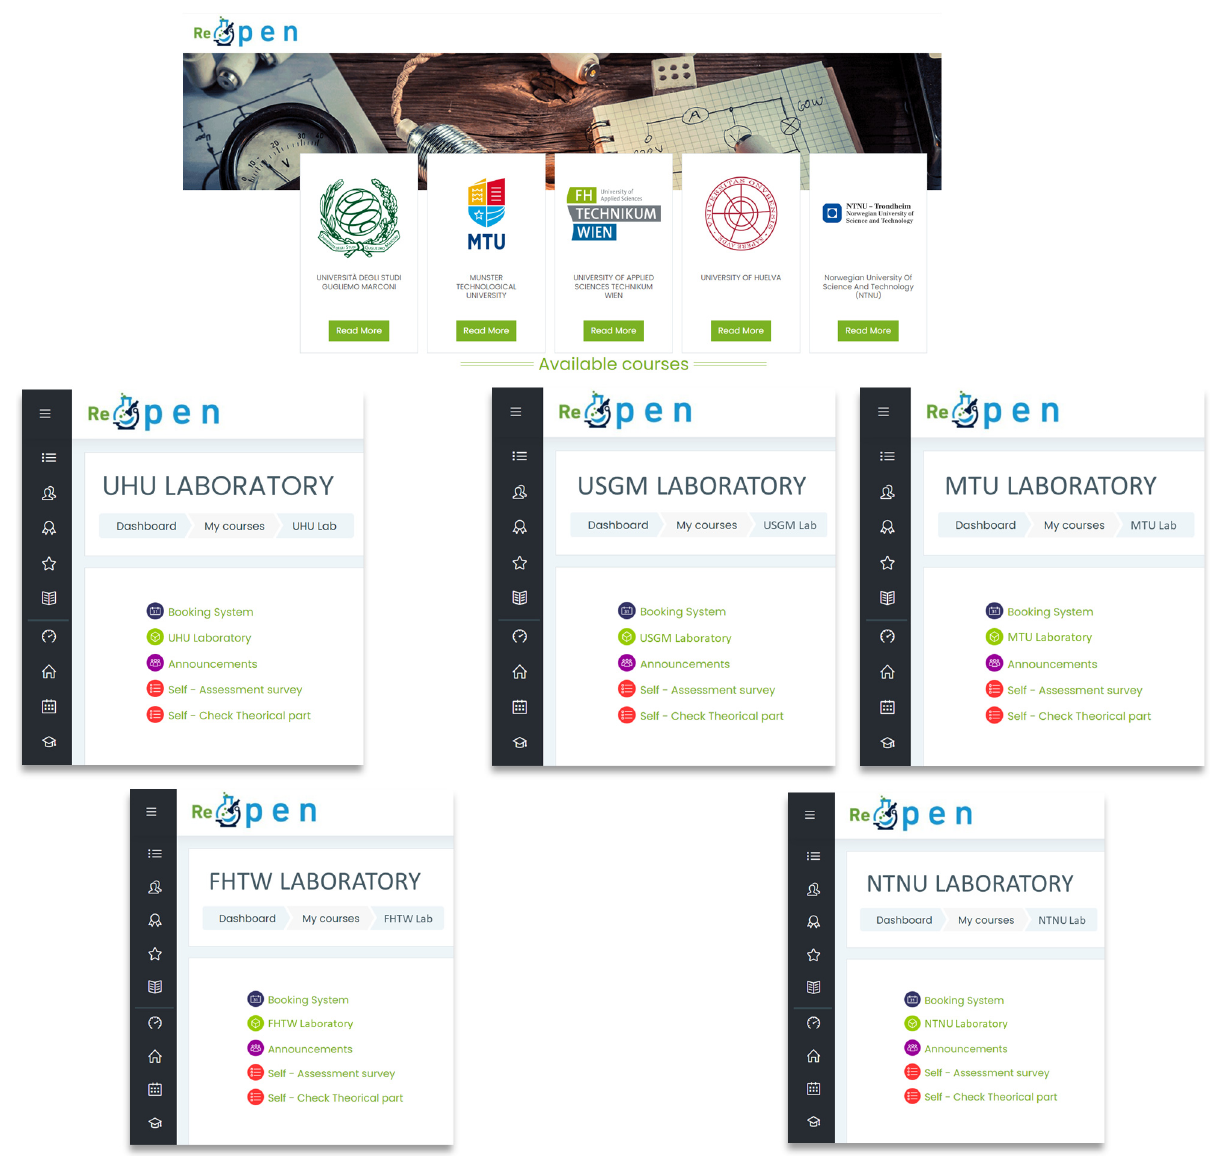
Figure 11. The student must be enrolled in a course at one of the five European universities.